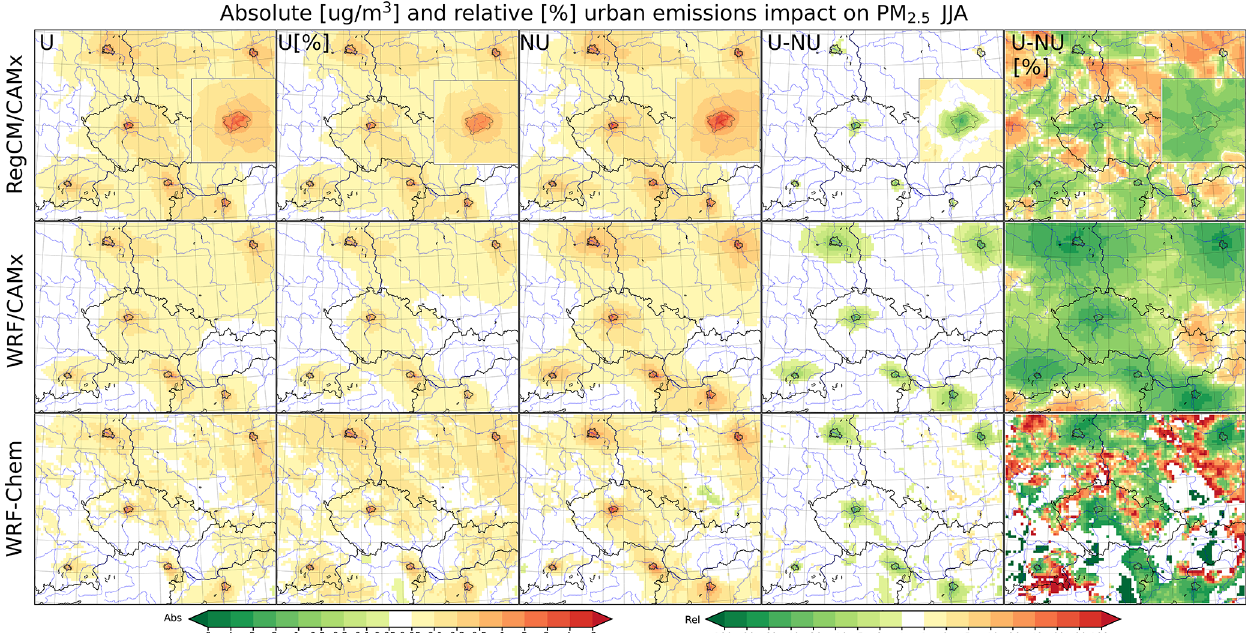
Figure 7. Same as Fig. 6 but for